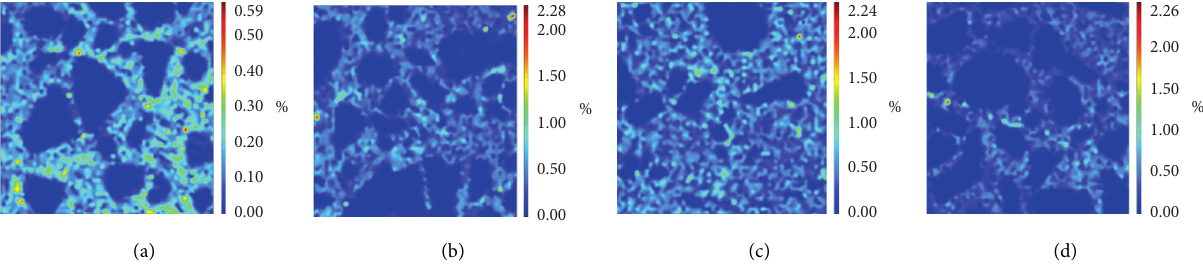
Figure 7: Cloud plots of initial porosity distribution of concrete after freeze-thawing. (a) ( n ) � 0. (b) ( n ) � 3. (c) ( n ) � 60. (d) ( n ) � 90.